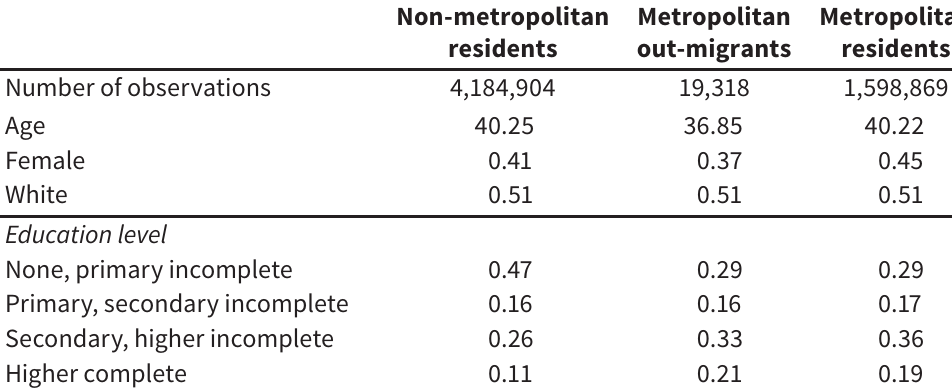
Characteristics of migrants and non-migrants 2010 Non-metropolitan